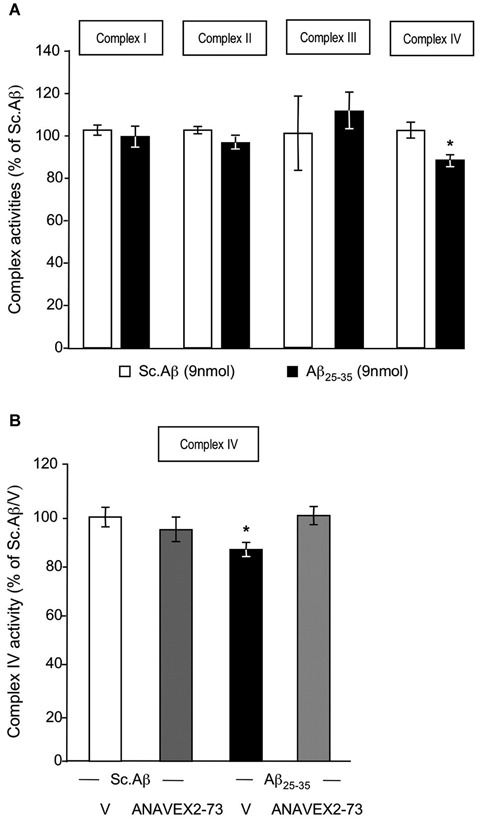
ANAVEX2-73 protected against Aβ25–35-induced alteration of complex IV activity. Mitochondria were loaded in the spectrophotometer cuvette with appropriate buffer at 30°C and variations of absorption were recorded after addition of specific substrates. (A) Effect of Aβ25–35 ICV injection on complex activities (% of Sc. Aβ) n = 8–9 per group, * p < 0.05 vs. Sc. Aβ Student’s t-test. (B) Mice were treated with ANAVEX2-73 (0.3 mg/kg IP) or vehicle, before injection of Sc. Aβ or Aβ25–35 (9 nmol ICV). Complex IV activity was measured after 7 days (% of Sc. Aβ). n = 5–9 per group, F(3,26) = 3.00, p < 0.05. * p < 0.05 vs. Sc. Aβ; Dunnett’s test.